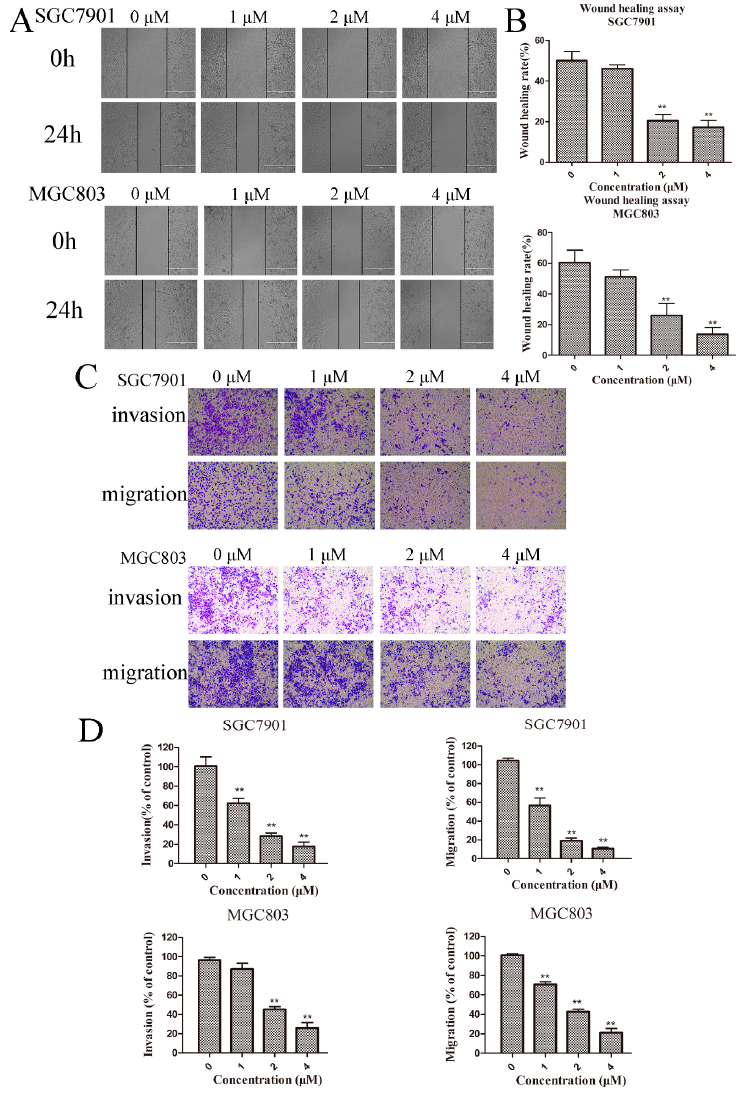
Figure 4. Zey inhibits the migration and invasion in SGC7901 and MGC803 cells. ( A ) Wound-healing assay in SGC7901 and MGC803 cells. After making a linear wound, cells were incubated with different concentrations of Zey (0, 1, 2, or 4 µ M) in serum-free RPMI-1640 for an additional 24 h. Wound healing was photographed at 0 and 24 h using a microscope with a magnification of 100 × . ( B ) Quantitative analysis of the ratio of wound healing. The data represented the means ± SD for triplicate determinations. * p < 0.05 and ** p < 0.01 vs. control cells. ( C ) Invasion and migration assay in SGC7901 and MGC803 cells. Images are shown under a light microscope with a magnification of 100 × . ( D ) Quantitative analysis of the ratio of invasion/migration in SGC7901 and MGC803 cells. The data represented the means ± SD of three distinct experiments. The control cells were regarded as 100% in the invasion/migration index calculation. * p < 0.05 and ** p < 0.01 vs. control